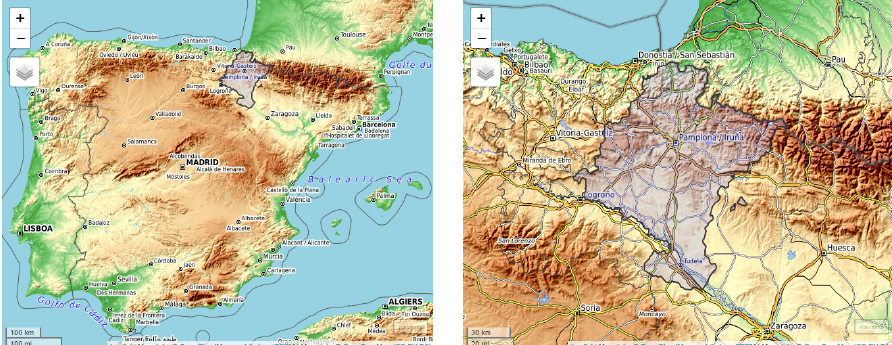
Figure 9. Map of the Navarre region that is located in the north of Spain; it has a common border with the south of